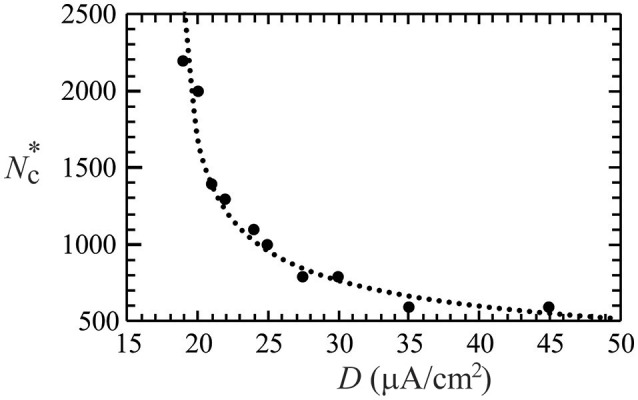
The threshold value (Nc*) of network connections to induce synchronous firing as a function of the standard deviation (D) of a Gaussian white noise. The dotted curve is a fit of the data points, which suggests no synchronization for D ≤ 18.5 μA/cm2. Data were calculated by averaging 30 realizations and using the following set of parameters: A+ = 0.013 and M = 50.